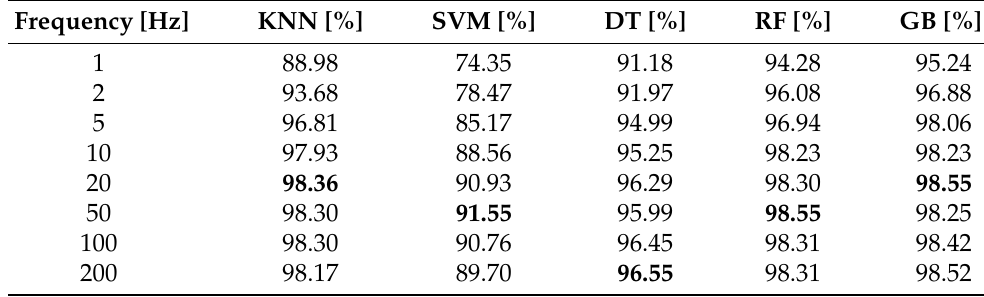
Table 8. Comparison of the F1-score across the ML algorithms, with the highest values in